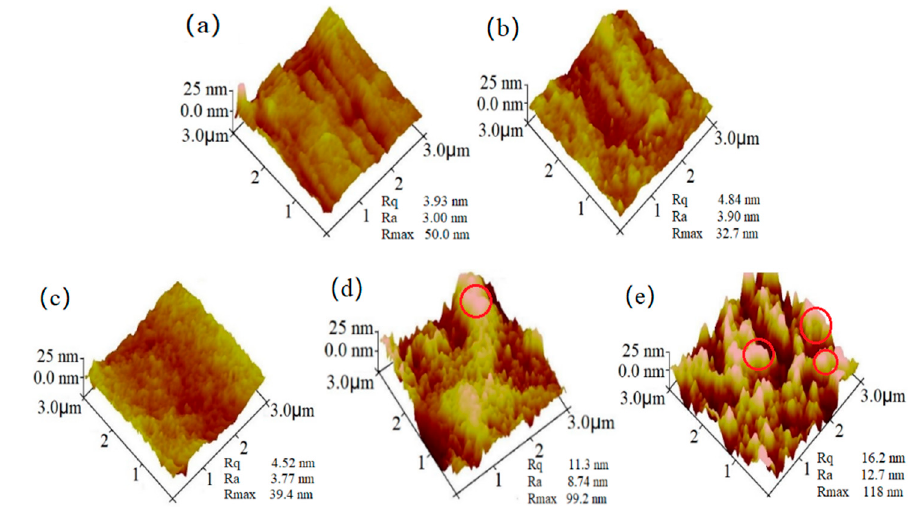
Figure 6. SEM micrographs of the composite films with various dosages of ZnO NPs: ( a ) 1%, ( b ) 3%, ( c ) 5%, ( d ) 7% and ( e ) 9% with 2 wt % carboxy methyl cellulose on a dry starch basis. The SEM magnification is ×2000.